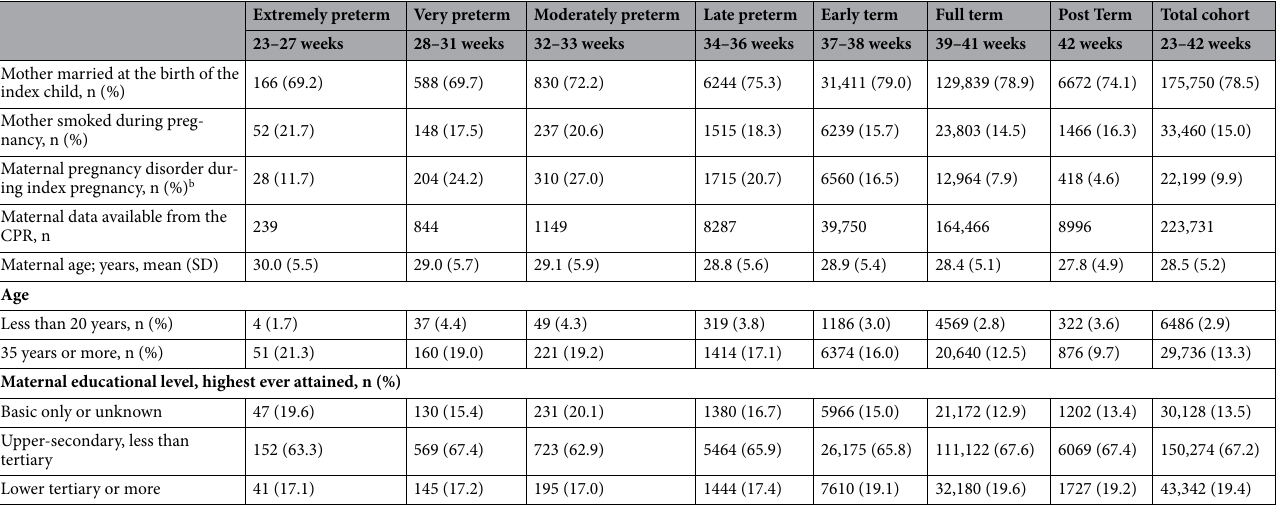
Table 2. Characteristics of the biological mothers of the individuals included to the study by GA a category. The amount of missing data was 0.0% (n = 14) for maternal education, 0.4% (n = 997) for maternal marital status at childbirth, and 1.9% (n = 4253) for maternal smoking in pregnancy. a GA—gestational age. Completed weeks of gestation. b Pregnancy disorder includes gestational diabetes, gestational hypertensive disorder, and intrahepatic cholestasis of pregnancy. A complete list of diagnose codes included in this variable is available from Supplementary Material and elsewhere 42 .